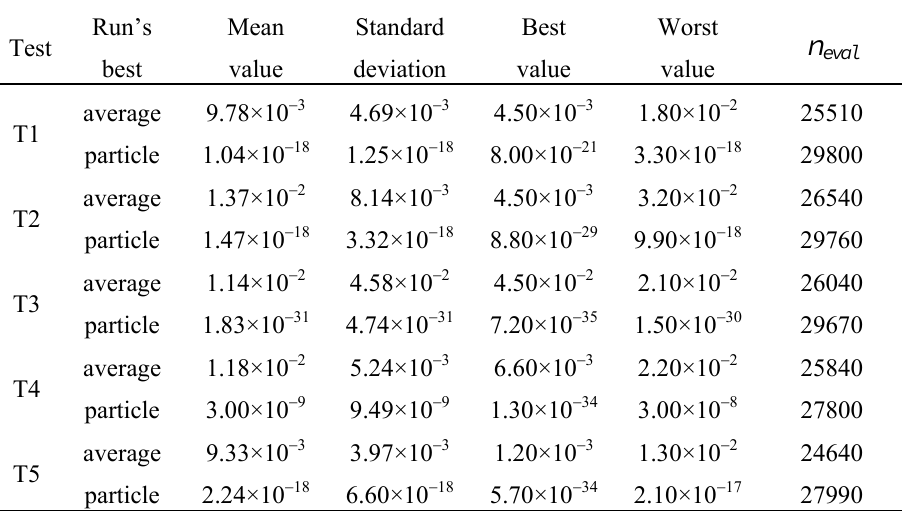
Table 4. Results of the tests T1 to T5 for example